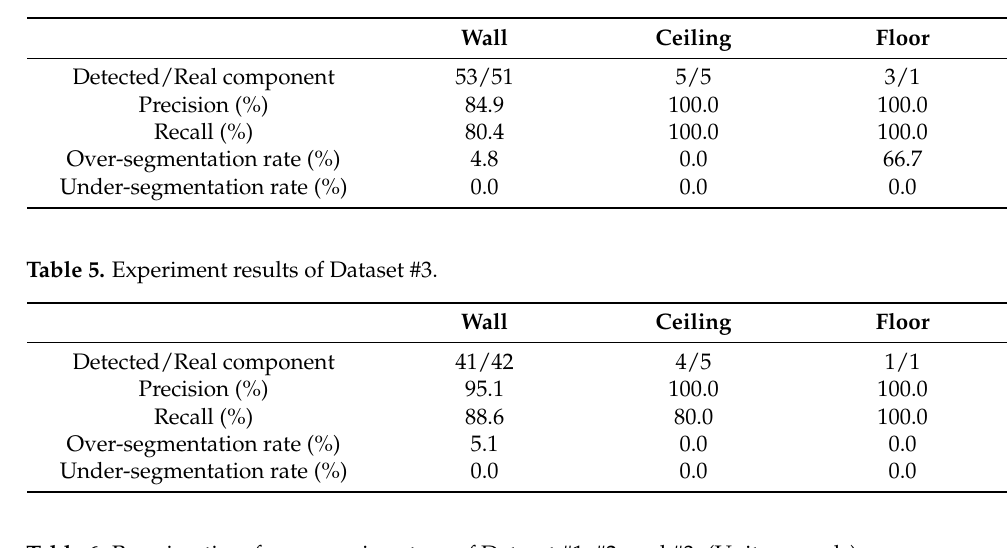
Table 4. Experiment results of Dataset #2.